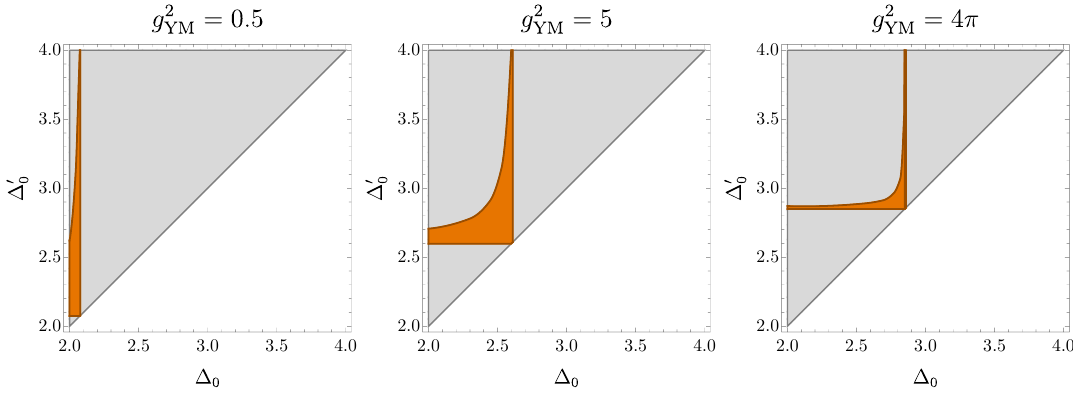
Figure 11 . The allowed values (orange) for the two lowest scalar operator scaling dimensions, ∆ 0 and ∆ 0 , within the gray region in which ∆ 0 < ∆ 0 , obtained with bootstrap resolution Λ = 39 for 0 0 the SU(2) theory with θ = 0 . Theories with ∆ 0 as low as the unitarity bound are allowed. However, if we assume some minimum value for ∆ 0 then we can extract lower bounds, as shown in figure 0